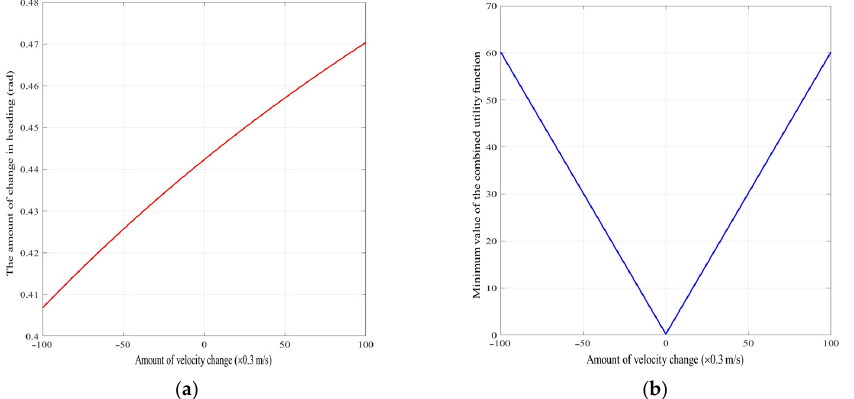
Figure 11. The relationship between the amount of speed change and the amount of heading change, and the integrated utility function: ( a ) the amount of speed change and heading change; ( b ) amount of velocity change and integrated utility function.